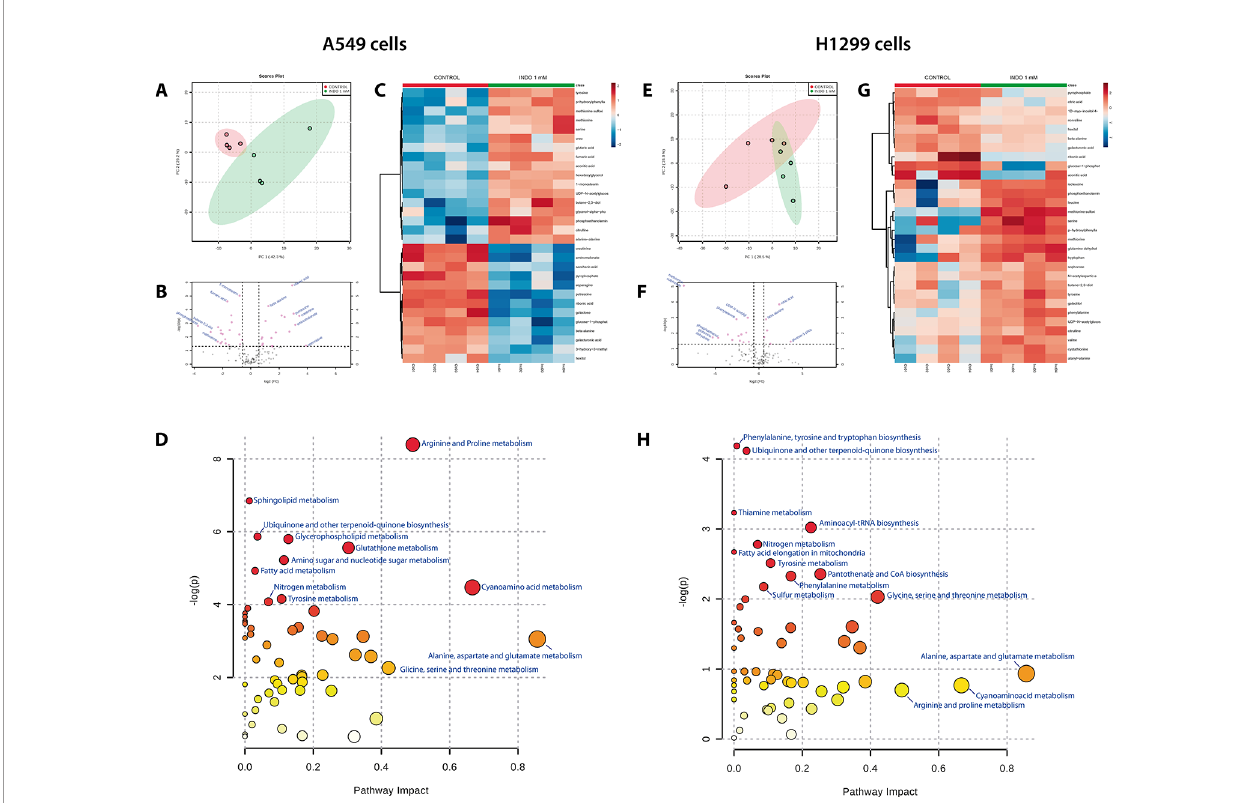
FIGURE 2 | Metabolomic analyses of non-small cell lung cancer (NSCLC) cells exposed to indomethacin. A549 and H1299 cells were exposed to indomethacin for 24 h. An unbiased metabolomics analysis was performed using gas chromatography/mass spectrometry (GC/MS). Identi fi ed compounds were analyzed using the MetaboAnalyst platform. (A, E) Principal component analyses (PCA) plots of A549 (A) and H1299 (E) cells. (B, F) Volcano plots showing metabolites identi fi ed in A549 (B) and H1299 (F) cells. Fold-change and p value thresholds were set at 1.5 and 0.05, respectively. The notated compounds in each graph are those which demonstrated statistical signi fi cance compared with untreated cells. (C, G) Heatmaps showing the 30 metabolites with greater variation observed in A549 (C) and H1299 (G) cells, comparing treated and untreated cells. (D, H) Overview of the pathway analysis in A549 (D) and H1299 (H) cells exposed to indomethacin. The scatter plots represent the pathway impact value and p value from the pathway topology analysis of the differentially expressed metabolite. The position of each node in the plot is based on its pathway impact (X-axis) value and p value (Y-axis). Pathways which demonstrated statistical signi fi cance ( p < 0.05, compared with untreated cells) are shown in red. Data summarize the results of four independent